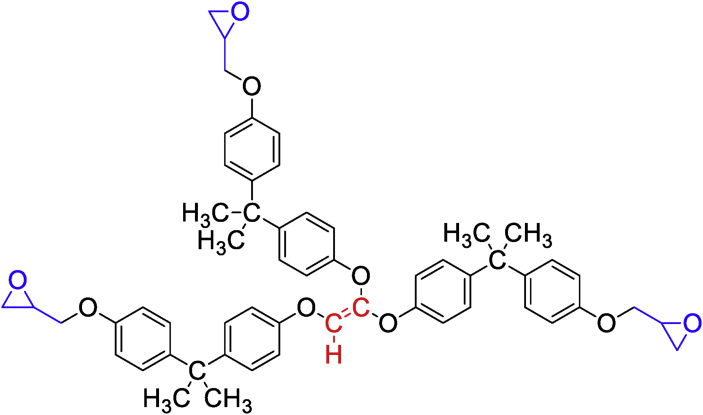
Structure of TGEEBA [40].